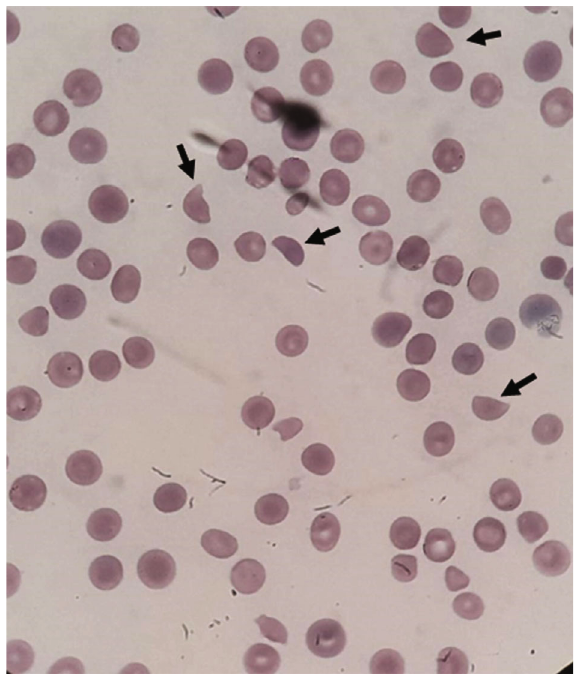
Figure 1: Peripheral blood smear examination revealing numerous schistocytes (arrows). These fi ndings are consistent with microangiopathic hemolytic anemia, one of the features of the classic TTP